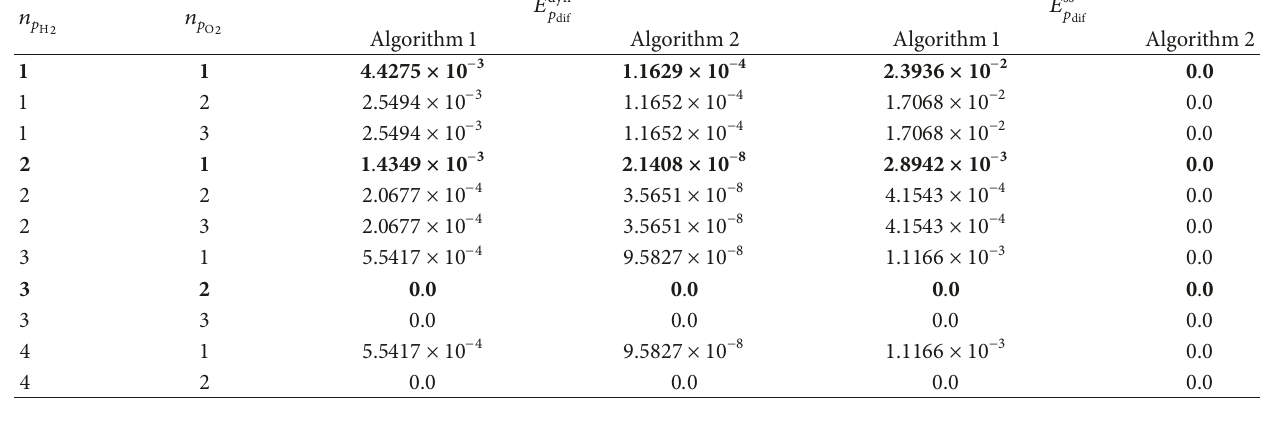
and 𝑛 𝑝 ) on the dynamic error 𝐸 dyn 𝑝 H 2 O 2